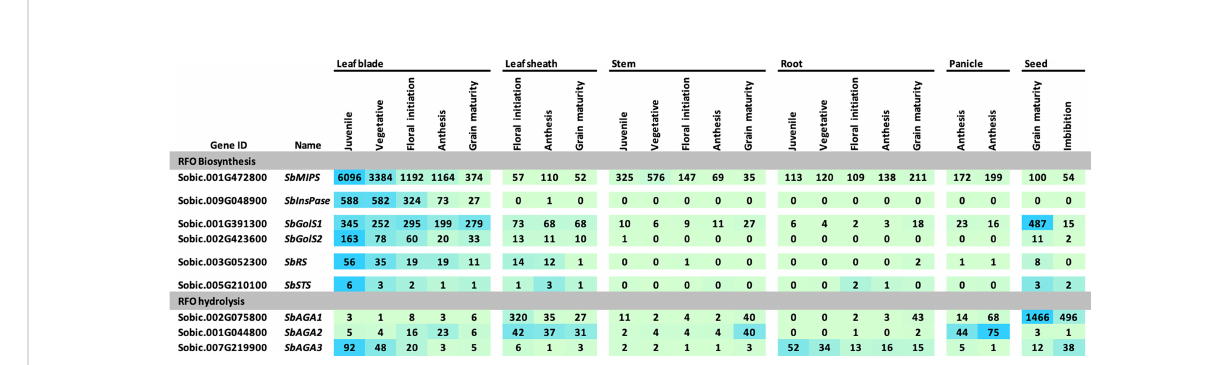
FIGURE 3 Expression of genes involved in RFO metabolism throughout various tissues and developmental stages of the grain sorghum BTx623. Numeric data represents TPM normalized expression. Each data point is the mean of three biological replicates. In the heat map, the darker the blue the higher the